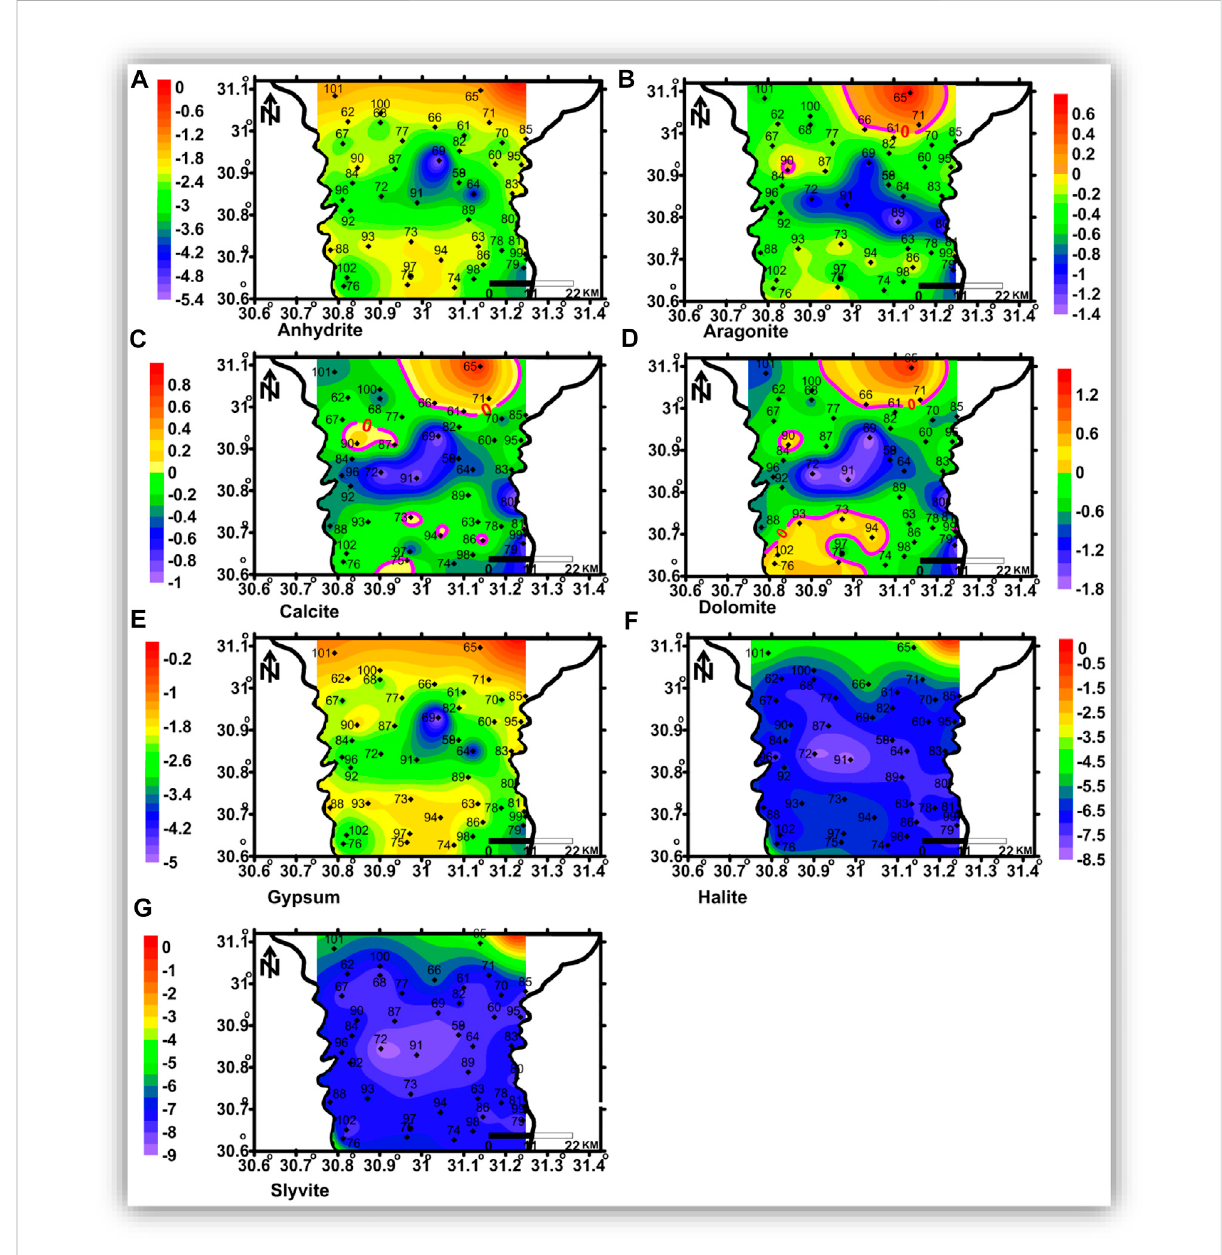
FIGURE 14 Spatial distribution maps of the dissolved minerals ’ saturation indices in the intermediate